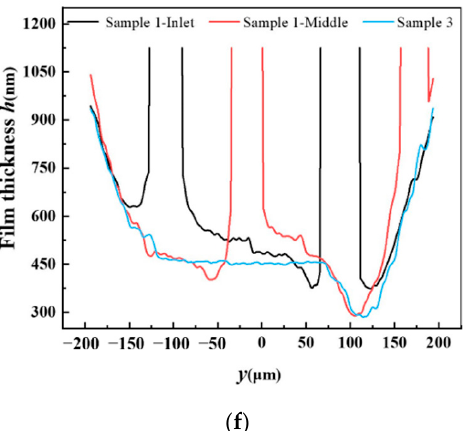
Figure 9. Film thickness profiles of sample 1 and the untextured ball along the sliding direction (load = 16.7 N): ( a ) distribution of film thickness—32 mm/s; ( b ) film thickness profile along the y direc ‐ tion—256 mm/s; ( c ) distribution of film thickness—256 mm/s; ( d ) film thickness profile along the y direction—256 mm/s; ( e ) distribution of film thickness—512 mm/s; and ( f ) film thickness profile along the y direction—512 mm/s.